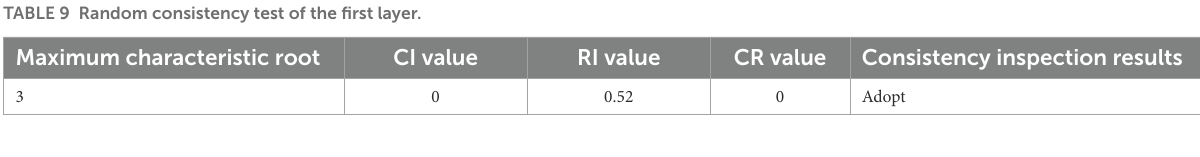
TABLE 10 Random consistency test of the second layer.